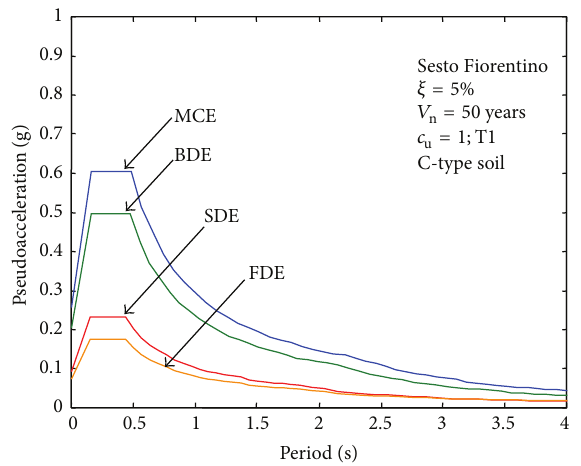
Figure4:Normativepseudoaccelerationelasticresponsespectrafor SestoFiorentino—FDE,SDE,BDE,andMCElevels, 𝜉 = 5 %, 𝑉 𝑛 = 50 = 1 , topographic category T1, and C-type years, 𝑐 u